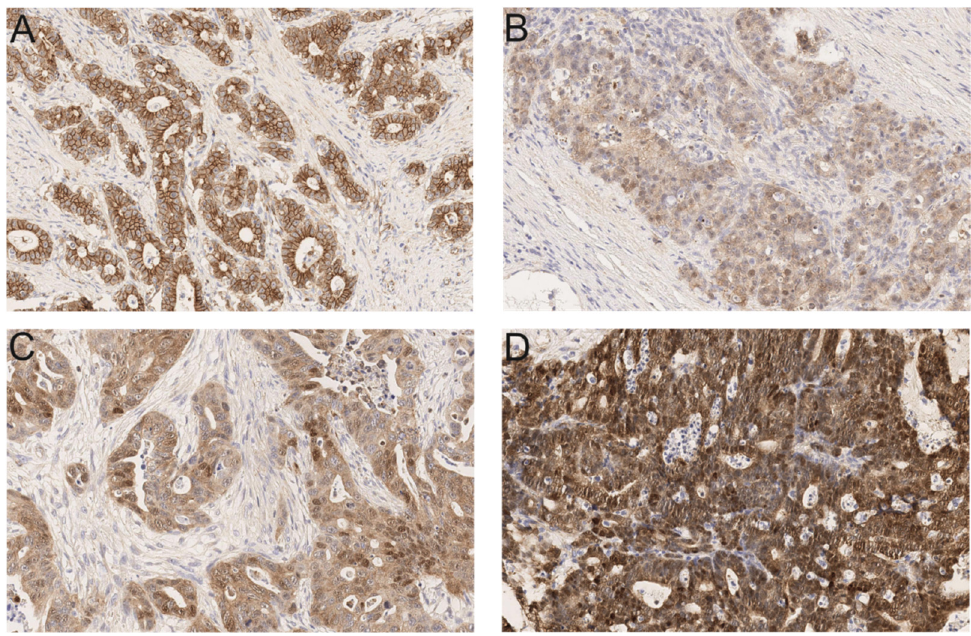
Figure 2. Scoring for nuclear translocated β -catenin in feline intestinal carcinomas (Anti- β -catenin; 20×). ( A ) Tumor with no or scattered (<5%) nuclear β -catenin staining (score 0); ( B ) 5–25% of tumor cells display nuclear positivity for β -catenin (score 1); ( C ) 26–50% of tumor cells display nuclear positivity (score 2); and ( D ) >50% of tumor cells are positive for nuclear β -catenin (score 3). For corresponding human β -catenin stainings see Figure